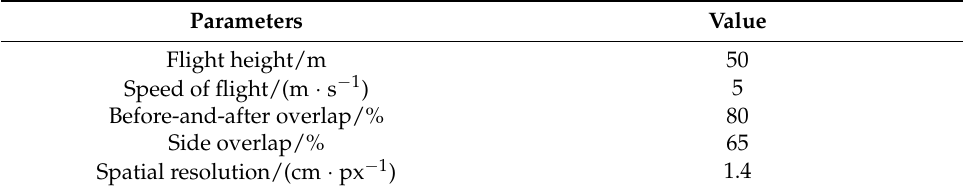
Table 1. Acquisition parameters for UAV image collection.